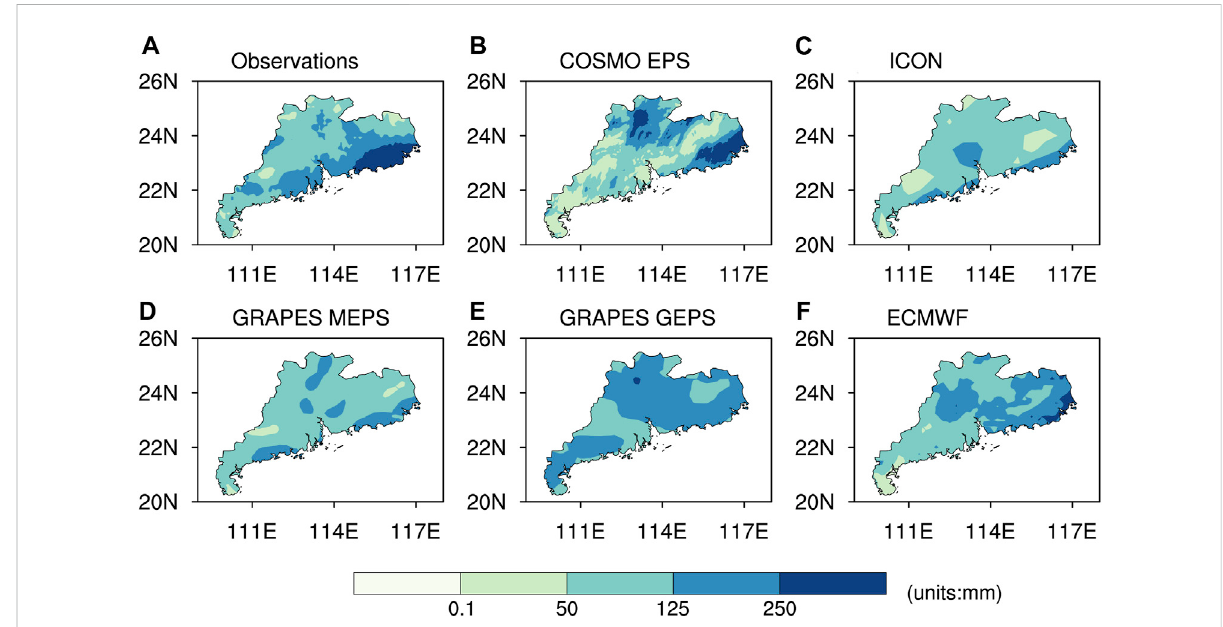
FIGURE 2 SpatialdistributionsofcumulativeprecipitationinGuangdong Provinceduringtheperiodof27 – 31August2018for (A) theobservations; (B) the ensemble median forecast of COSMO EPS based on the COSMO-noLHN experiment (i.e., pure downscaling of ICON global predictions); (C) the deterministic forecast of the ICON global model; (D – E) the ensemble median forecast of GRAPES MEPS and GRAPES GEPS, respectively; (F) the deterministic forecast of ECMWF global